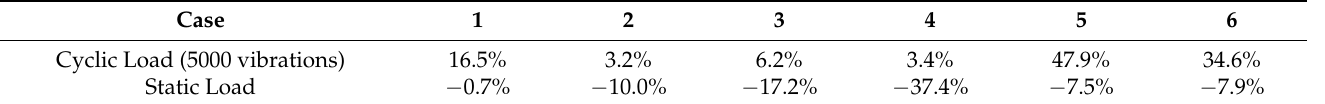
Table 7. Percentage difference between test and analog value of vertical